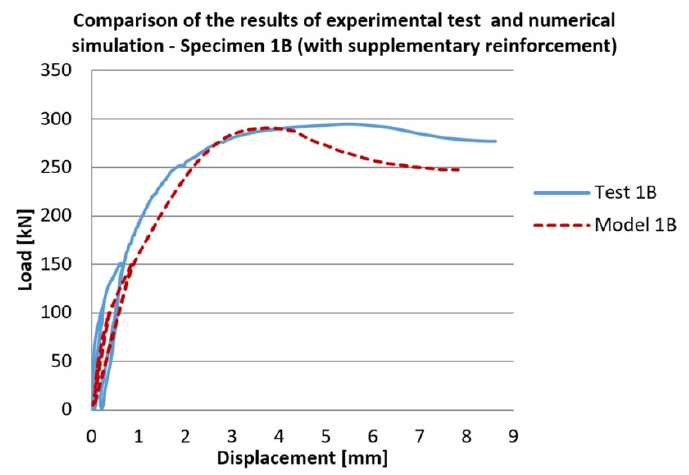
Figure 17. Comparison of results of the experimental test with numerical simulation—specimen with supplementary reinforcement.